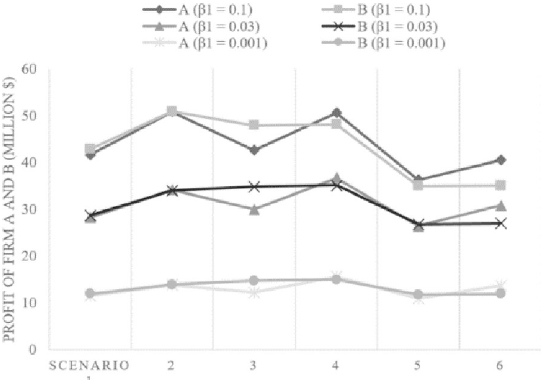
Fig 6. Net profit changes with different β 1 , which is related to the innovation coefficient p